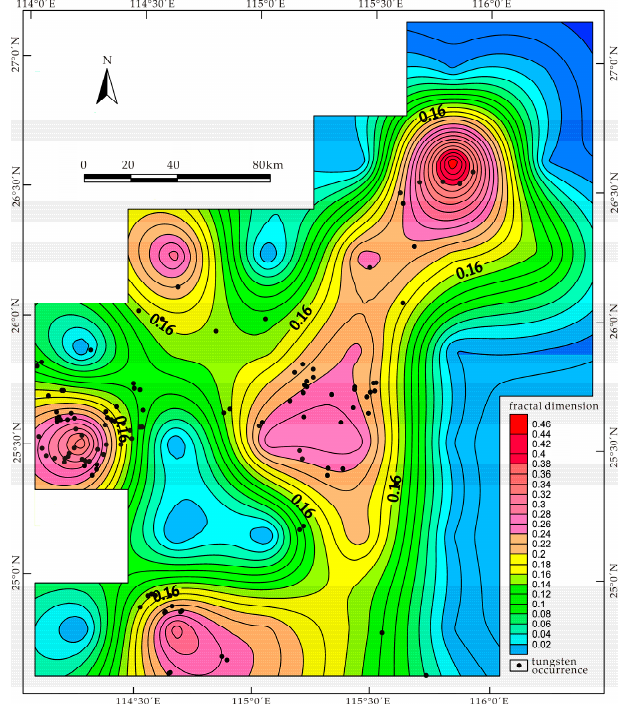
Figure 6. Contour map showing spatial distribution of fractal dimensions of fault intersections.